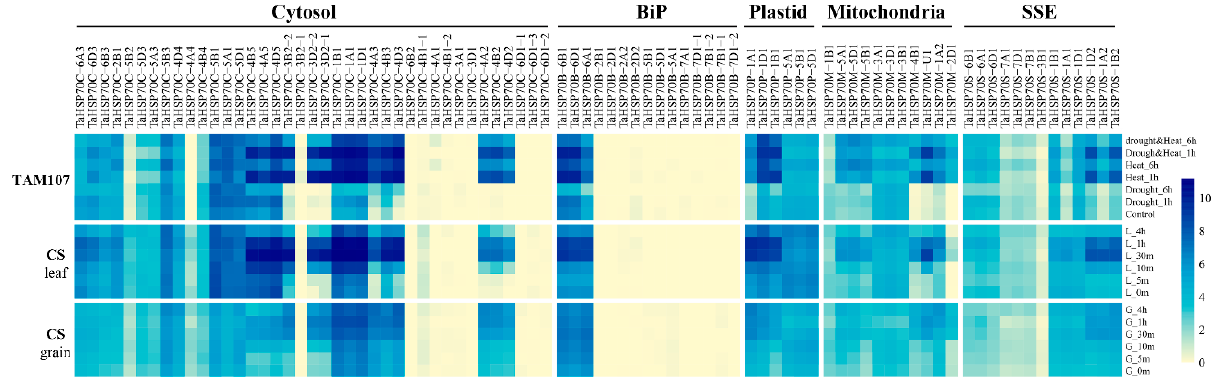
Figure 8. Heat expression profiles of TaHSP70s in different wheat varieties. Expression abundance is shown as log 2 (tpm + 1).